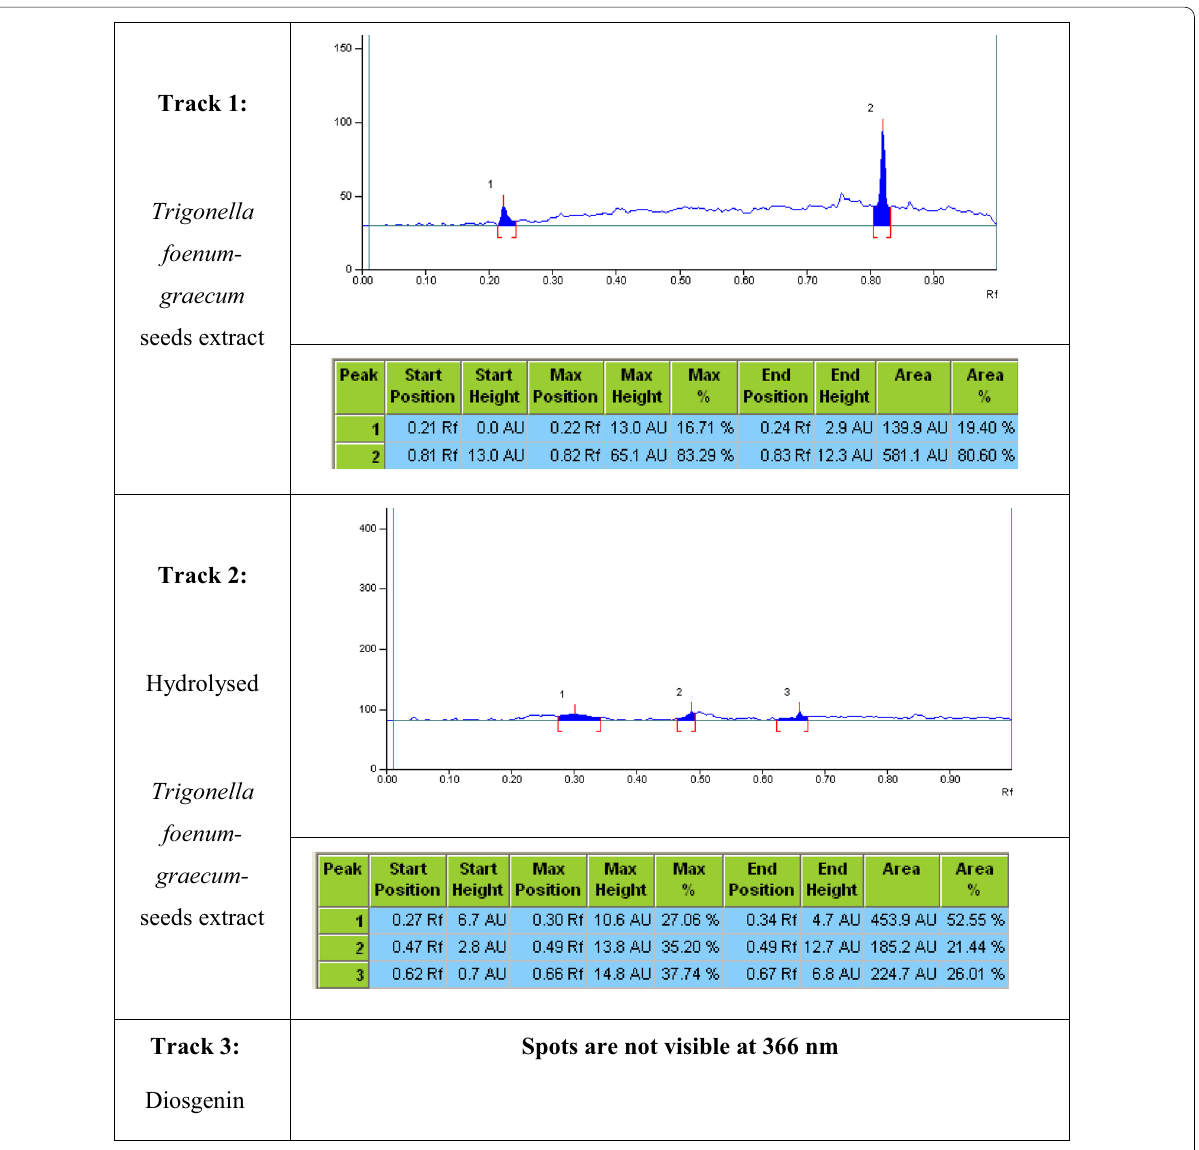
Fig. 5 HPTLC fingerprint profiles of Trigonella foenum-graecum seeds extract, coded ayurvedic formulation extract and Diosgenin reference standard at UV 366